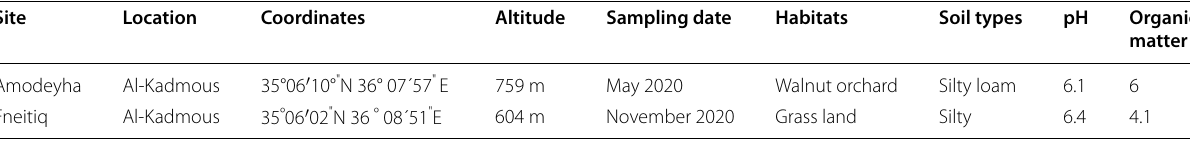
Table 1 Locality, habitat, sampling date, and soil characteristics of positive samples